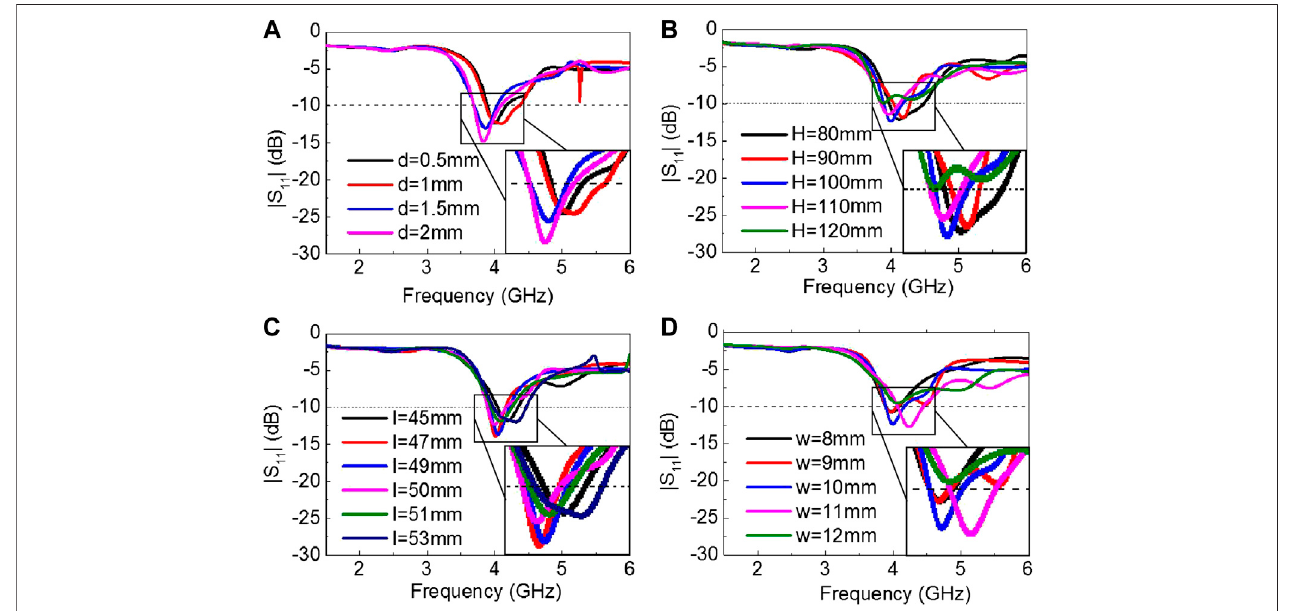
FIGURE 8 | Geometric parameters (A) the thickness of the dielectric substrate-d, (B) the height of outer hexagon for the dielectric substrate-H, (C) the length of antenna arm-I, and (D) the width of antenna arm-w) effect on antenna frequency.